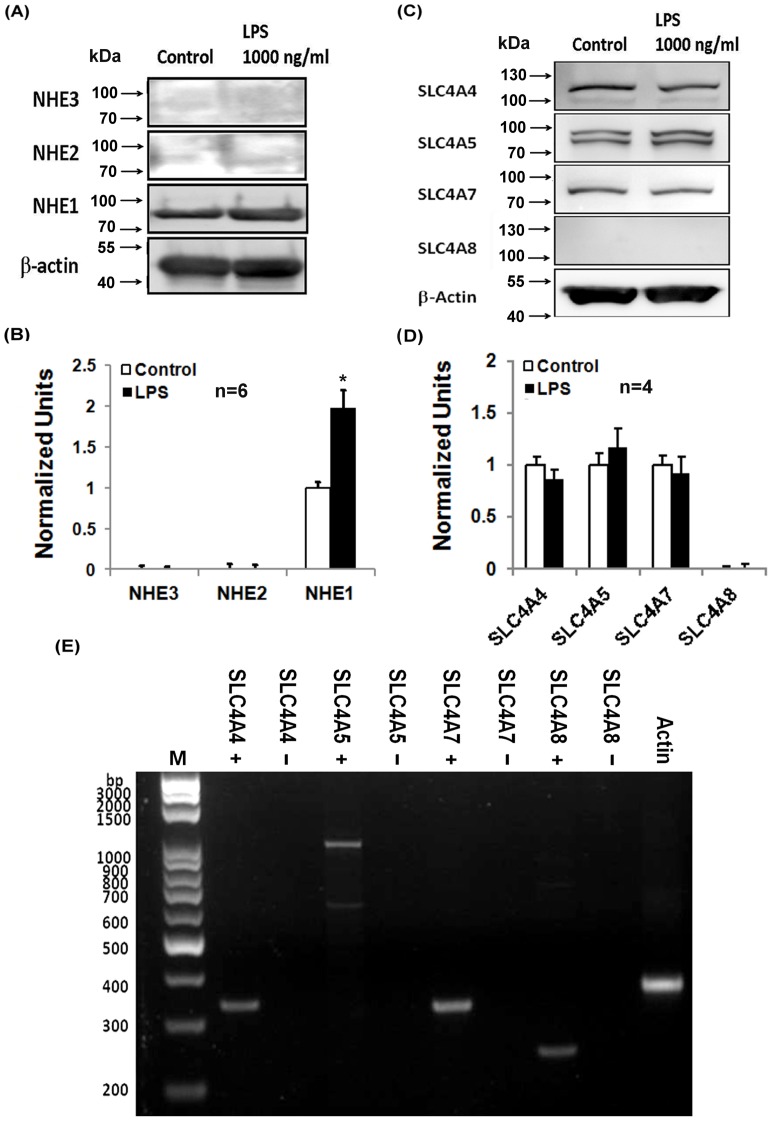
The effect of LPS on protein expression of NHE, NBC and intracellular resting pH in HRASMCs.
A: The figure shows the result of Western blot analysis for β-actin, NHE 1, 2 and 3, from the bottom to the top, respectively, before (left part) and after (right part) the 1000 ng/ml LPS treatment (n = 4). B: The histogram shows relative protein expression, as an average of 6 experiments, which is similar to that shown in A. Data is shown as the mean ± SEM (p<0.01; n = 6). C: The figure shows the result of Western blot analysis for β-actin, SLC4A8 (NBCBE), SLC4A7 (NBCn1), SLC4A5 (NBCe2) and SLC4A4 (NBCe1), from the bottom to the top, respectively, before (left part) and after (right part) the 1000 ng/ml LPS treatment (n = 4). D: The histogram shows the protein expression, as an average of 4 experiments, which is similar to that shown in C. Data is shown as the mean ± SEM (p<0.01; n = 4). E: Gene expression of mRNA of different members of SLC4 family: NBCe1 (SLC4A4; 336 bp), NBCe2 (SLC4A5; 650 bp and 1 kb), NBCn1 (SLC4A7; 328 bp) and NDCBE1 (SLC4A8; 243 bp) extracted from HRASMCs by RT-PCR. Actin expression was used as control (373 bp). bp denotes base pairs; M denotes marker; + denotes the presence of template; − denotes the absence of template (negative control).